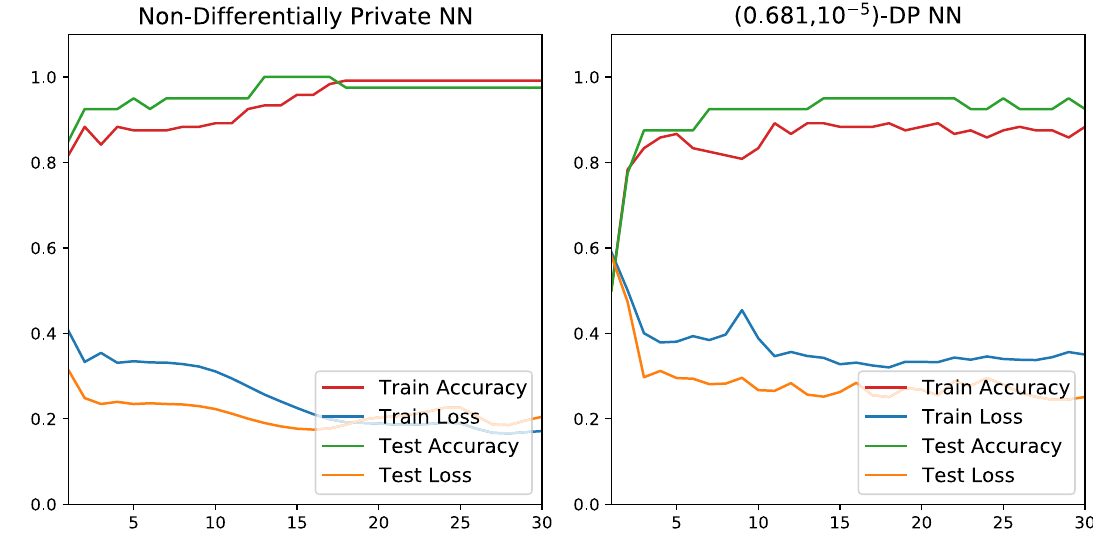
Figure 9. Results for “moons” classical classifier with 200 samples in total, 120 for training and 80 for testing, a learning rate of 0.05, and RMSprop optimizer with and without DP.